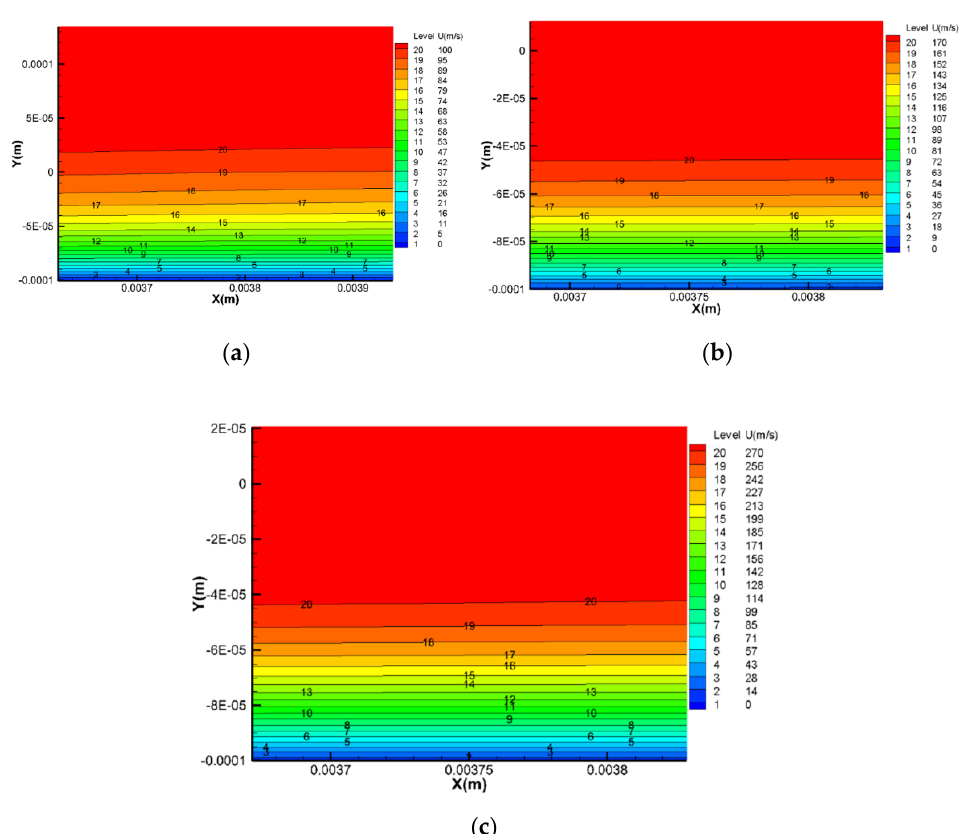
Figure 22. Spanwise plane velocity cloud picture of rectangular groove plate under different Mach numbers; ( a ) 0.3 Ma; ( b ) 0.5 Ma; and ( c ) 0.8 Ma.